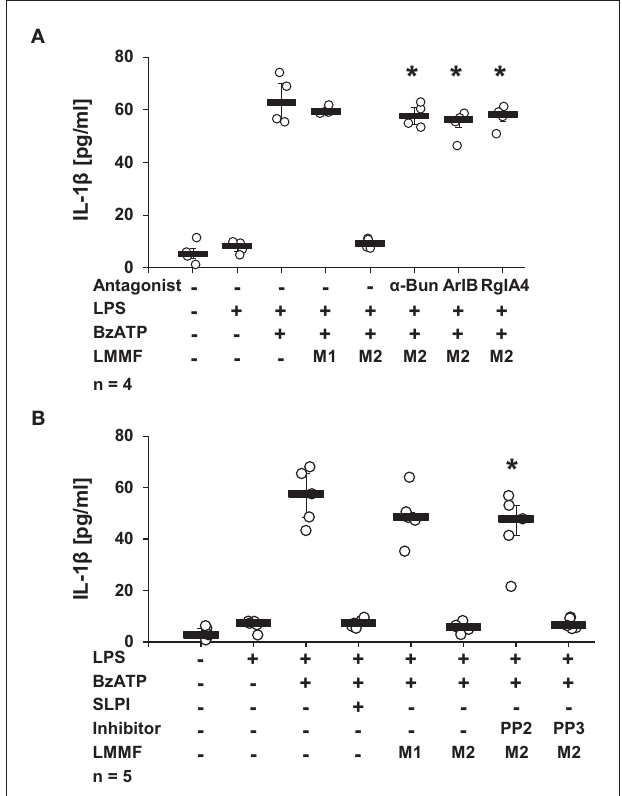
FIGURE 13 | The bioactive factor signals via nicotinic acetylcholine receptor (nAChR) subunits α 7, α 9, and α 10 and Src kinase. Human monocytic U937 cells were primed with LPS (1 µ g/ml) for 5h and cultured for additional 30min in the absence (M1) or presence (M2) of SLPI (10 µ g/ml). Conditioned media were collected and separated by ultrafiltration (cut-off 3 kDa) into high (HMMF) and low molecular mass fractions (LMMF). Conditioned medium M1 was supplemented with SLPI shortly before ultrafiltration. LPS-primed U937 cells were stimulated with 2 ′ (3 ′ )-O-(4-benzoylbenzoyl)adenosine 5 ′ -triphosphate triethylammonium salt (BzATP; 100mM) for 30min in the presence or absence of M1 or M2. (A) Application of nicotinic antagonists α -bungarotoxin ( α -Bun), RgIA4, or ArIB or (B) treatment with the Src kinase inhibitor PP2 abolished the inhibition mediated by the LMMF of M2. The inactive PP2 analogue PP3 had no effect on the inhibitory function of the LMMF of M2. * p ≤ 0.05 significantly different compared to U937 cells treated with LPS, BzATP, and LMMF of M2. Experimental groups were compared by Kruskal-Wallis test followed by Mann-Whitney rank sum test.